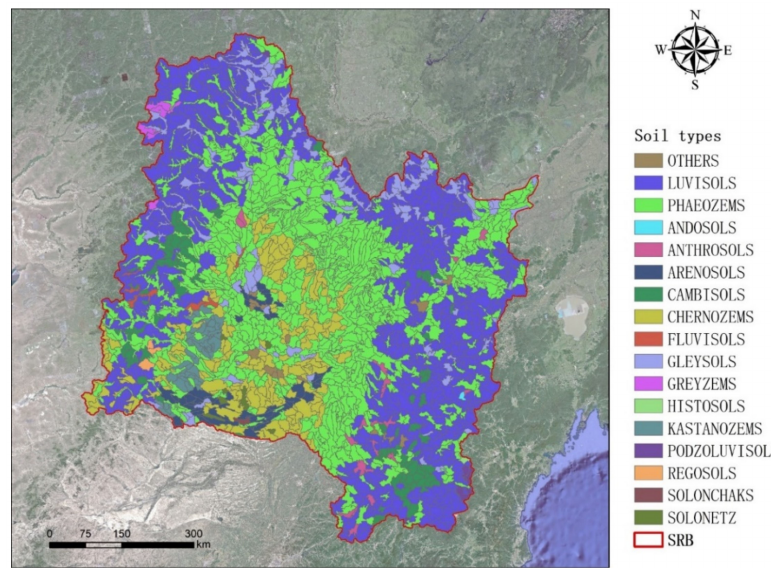
Figure 9. Distribution map of soil